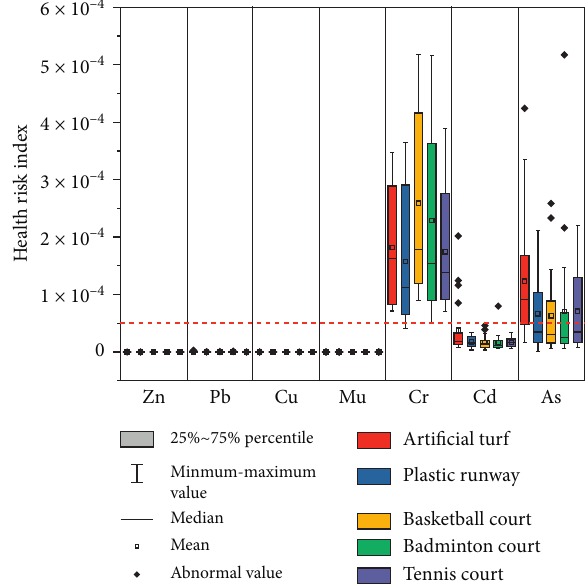
Figure 6: Health risk assessment result of heavy metals and metalloid in five athletic field